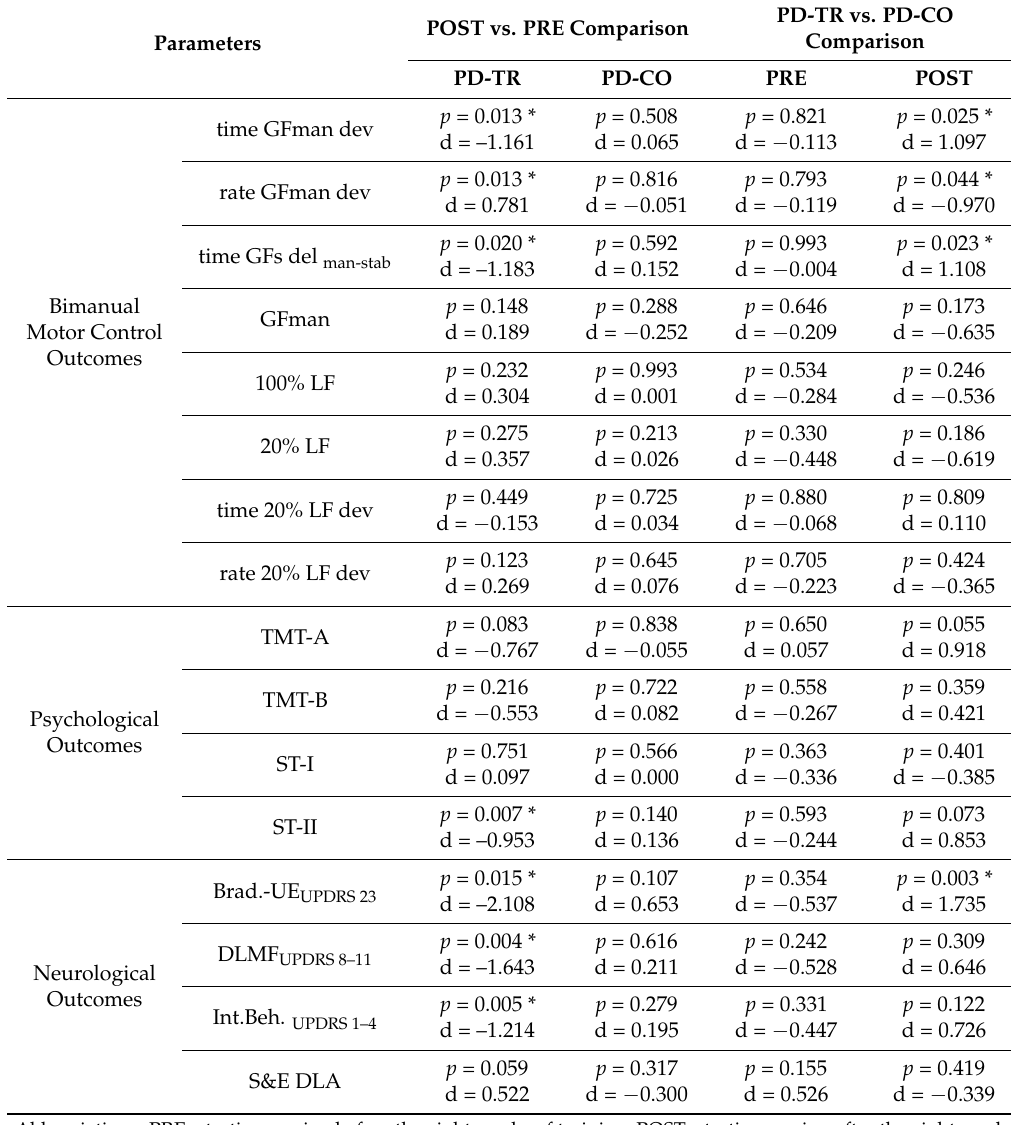
Table 2. Significance ( p ) and effect size (d) values for the parameter comparisons between the testing sessions (POST vs. PRE) and the tested groups (PD-TR, n = 10 vs. PD-CO, n = 10). PD-TR vs. PD-CO POST vs. PRE Comparison Comparison Parameters PD-TR PD-CO PRE POST